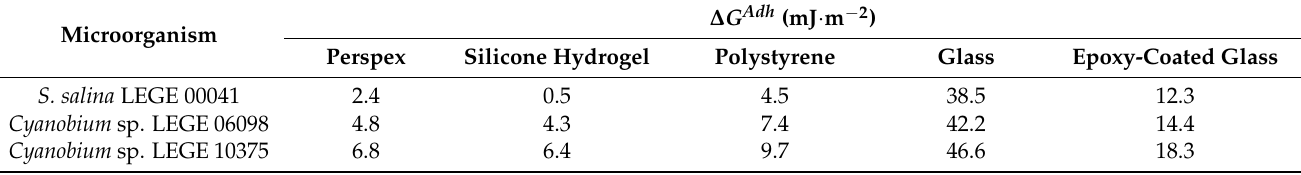
Table 3. Free energy of the interaction between cyanobacterial strains and tested surfaces (according to Equation (5)).